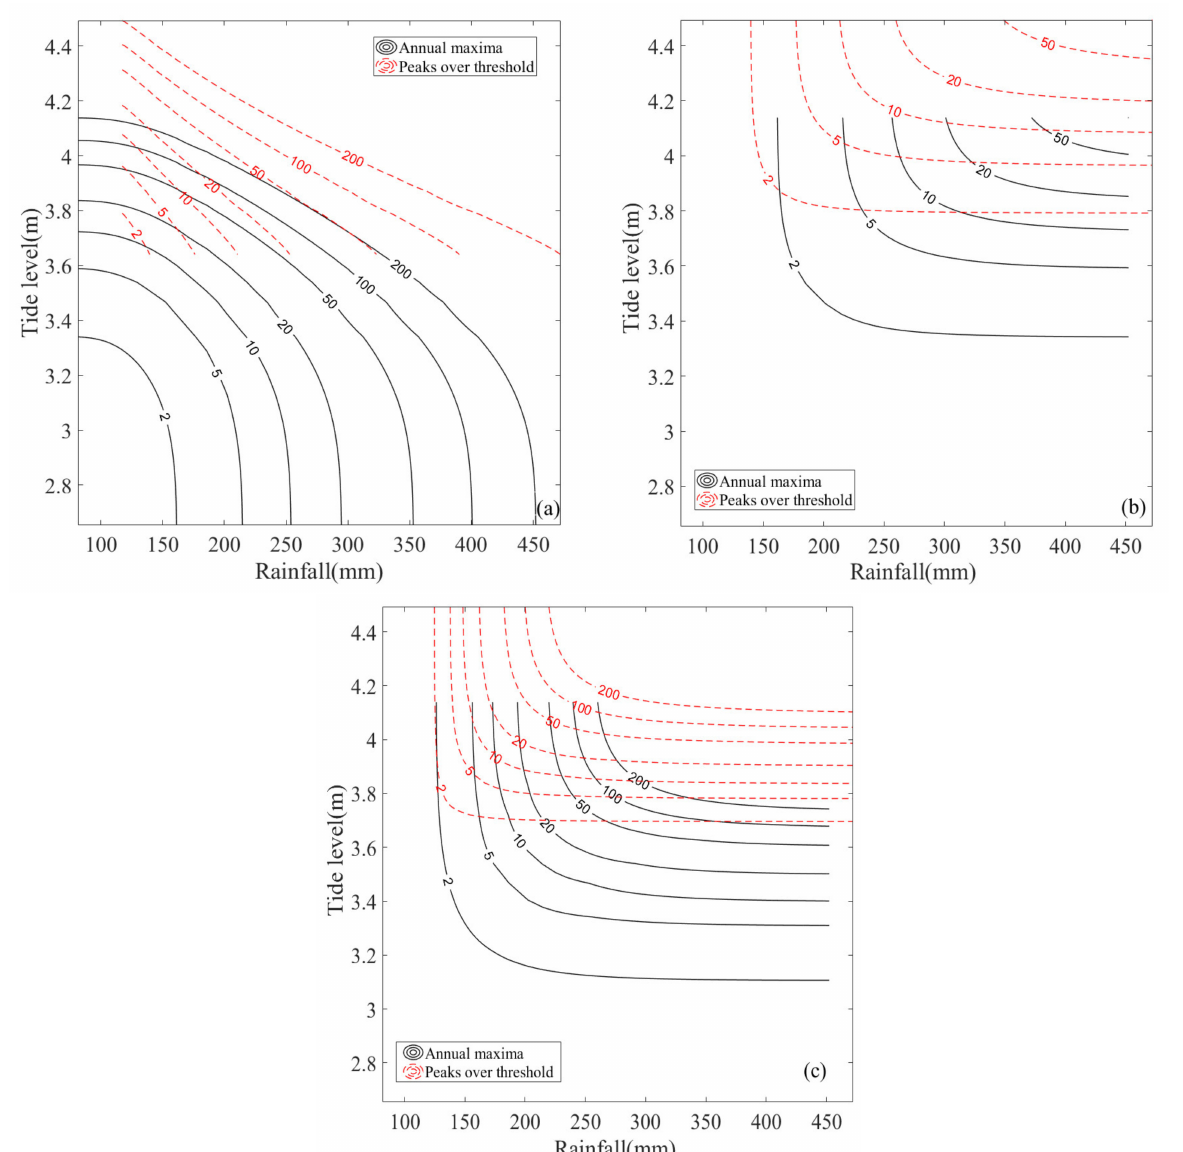
Figure 8. Comparison of the joint return periods for different sampling methods, ( a ) “AND” cases, ( b ) “OR” cases, and ( c ) Kendall